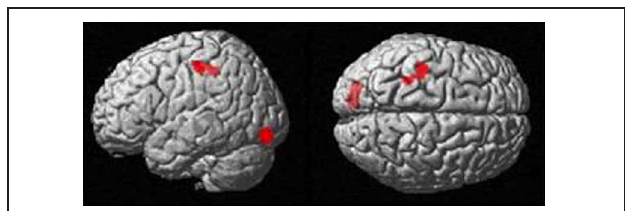
FIGURE 6 | Group BOLD response in positive correlation with speed RMSE data ( p < 0 . 05 FWE-corr.).